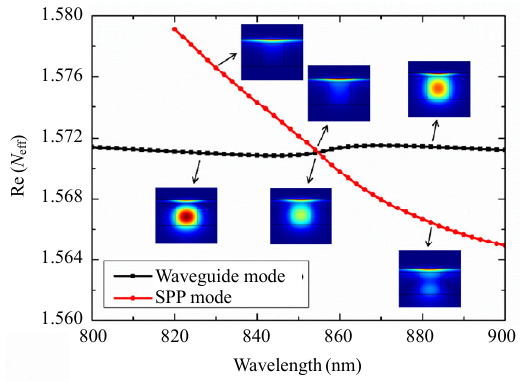
Fig. 2 Dispertion curves of the waveguide and SPP mode when w = h = 3 μ m, d Au = 50 nm, and t b = 500 nm.